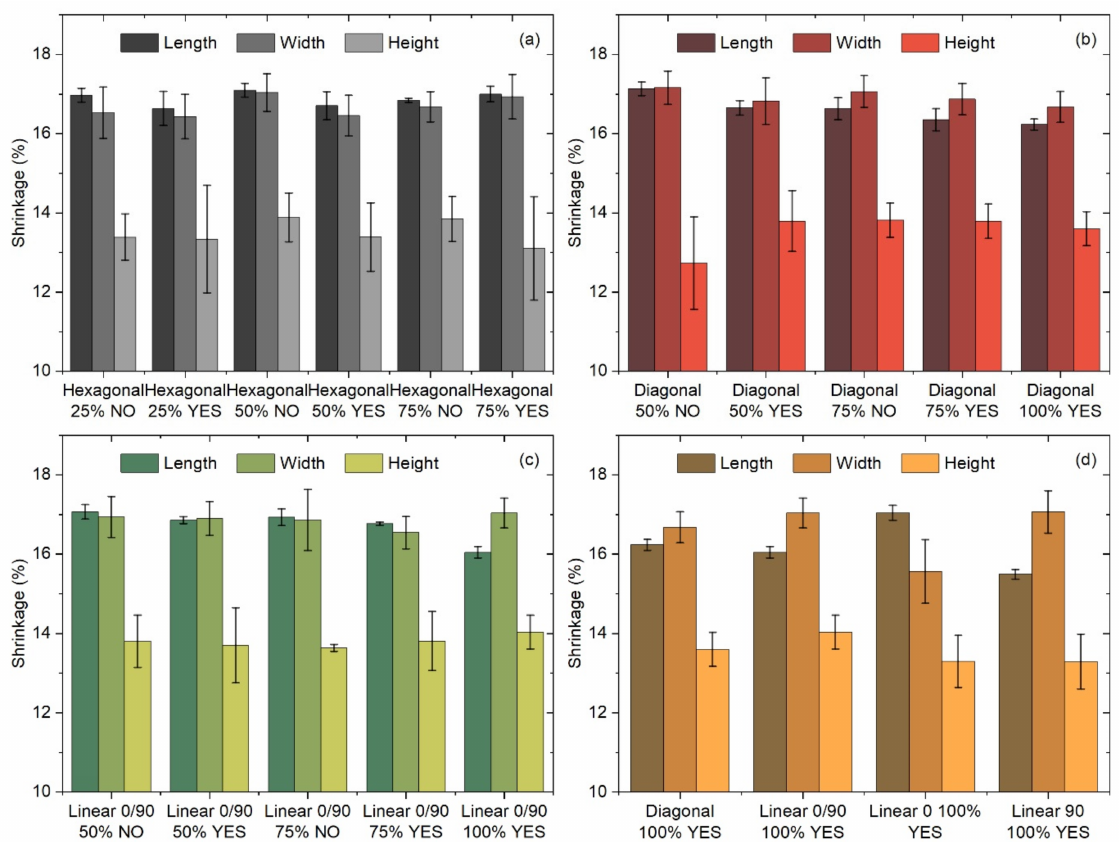
Figure 8. Shrinkage for the various specimens with different infill patterns and infill degrees ( a ) hexagonal 25 to 75%, ( b ) diagonal 50 to 100%, ( c ) linear 0/90 50 to 100%, and ( d ) 100% diagonal and lineal at different